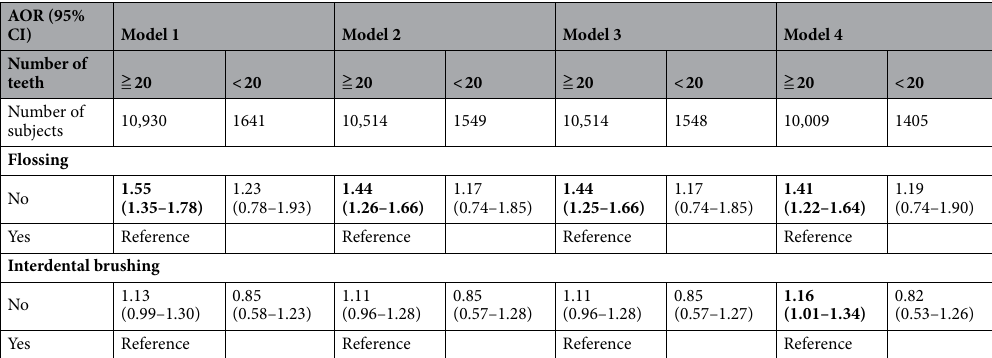
Table 2. Multivariable association between interdental cleaner use and periodontitis. AOR adjusted odds ratio, CI confidence interval. Bold denotes statistical significance at P < 0.05. Response variable: Periodontitis. Explanatory variable: Interdental cleaner. Model 1 was adjusted for age and sex. Model 2 was adjusted for age, sex, household income, and educational level. Model 3 was adjusted for age, sex, household income,